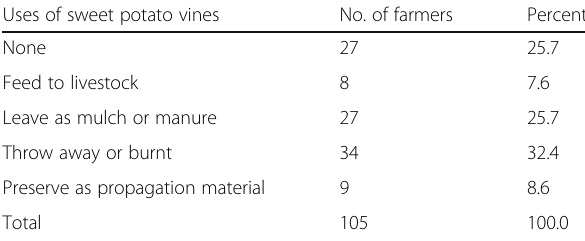
Table 3 Uses of sweet potato